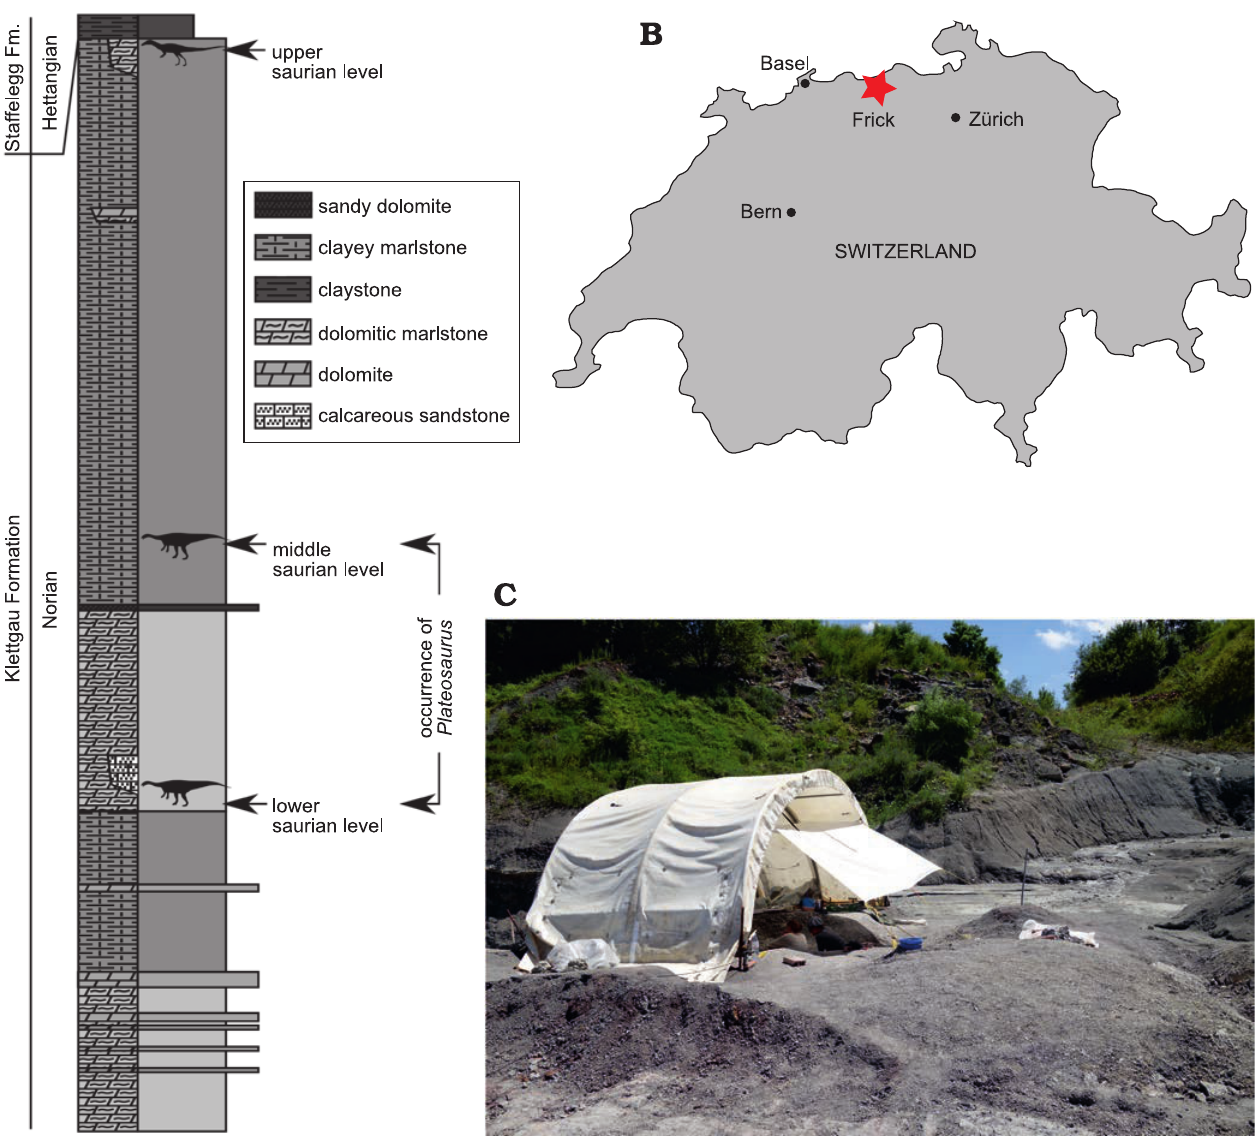
Fig. 1. A . Stratigraphic section of the Gruhalde Member of the Klettgau Formation as exposed in the Gruhalde Quarry in Frick, redrawn from Jordan et al. 2016 and Nau et al. 2020 (CC BY). The studied Plateosaurus material comes from the lower and middle bonebeds, which are separated by a dolomite marker horizon. B . Location of Frick (star) in Switzerland. C . Excavation of the find MSF 15.8 in the Gruhalde Quarry in July